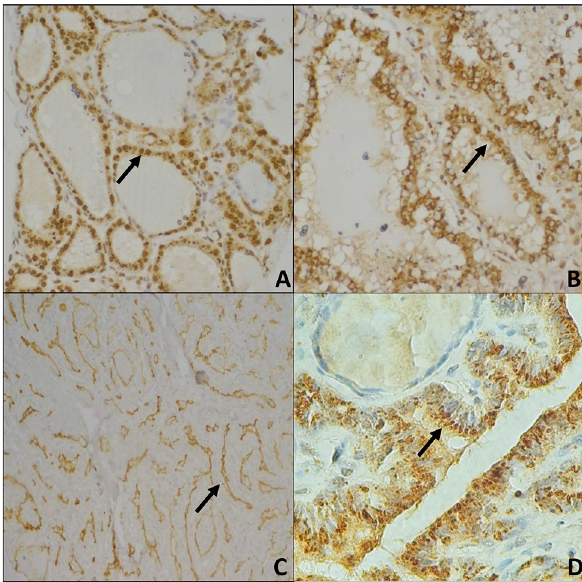
Figure 1. Protein expression evaluated from immunoistochemistry reaction. ( A ) Nuclear expression of L-selectin (20x); ( B ) Cytoplasmatic expression of L-selectin (20x); ( C ) Cytoplasmic Apical expression of ICAM-1 (10x) and; ( D ) Cytoplasmic expression of CD11a